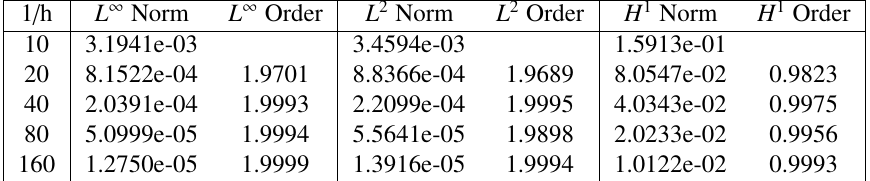
Table 4. Errors and Convergence Rate for Linear IFEM-CN Approximation for Example 1